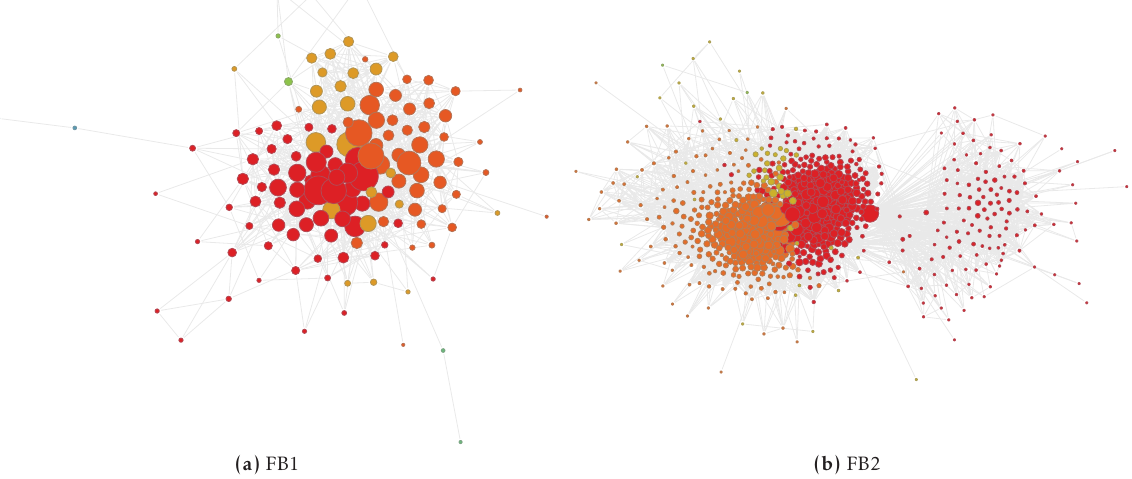
Figure 5. The Facebook friend networks used in the simulations. Network FB1 and FB2 are comprised of 151 and 502 nodes respectively. Table 2. Values Assigned to Specific Parameters in order to Obtain the Presented Results Parameter